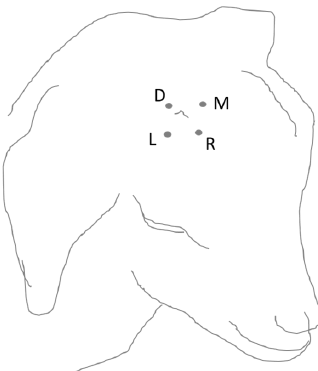
Figure 2. The drawing shows a scheme of the four locations around the horn bud used for MNT measurement (only right horn bud shown on drawing). L, lateral; D, dorsal; M, medial; R,